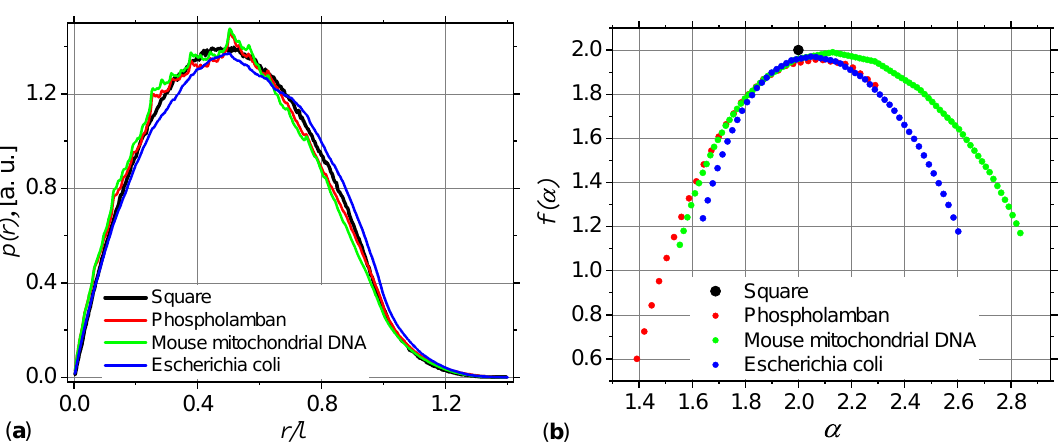
Figure 12. Pddf ( a ) and f ( α ) spectra ( b ) for Phospholamban Mouse mitochondrion DNA and Escherichia coli . The data for a uniform square are included for